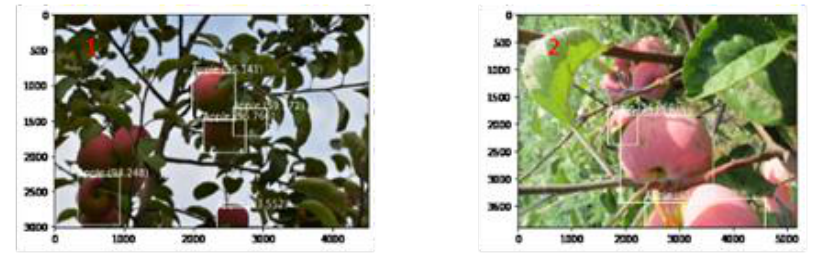
Figure 12. Examples of a partial detection of apples in clusters.